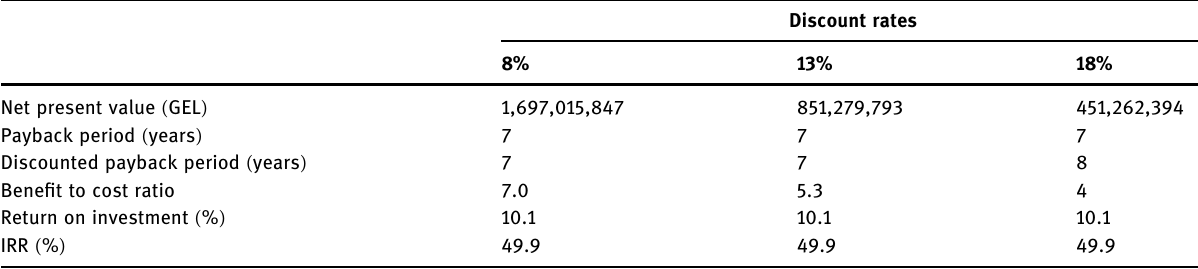
Table 4: Results of the fi nancial analysis of the project “ Plant the Future